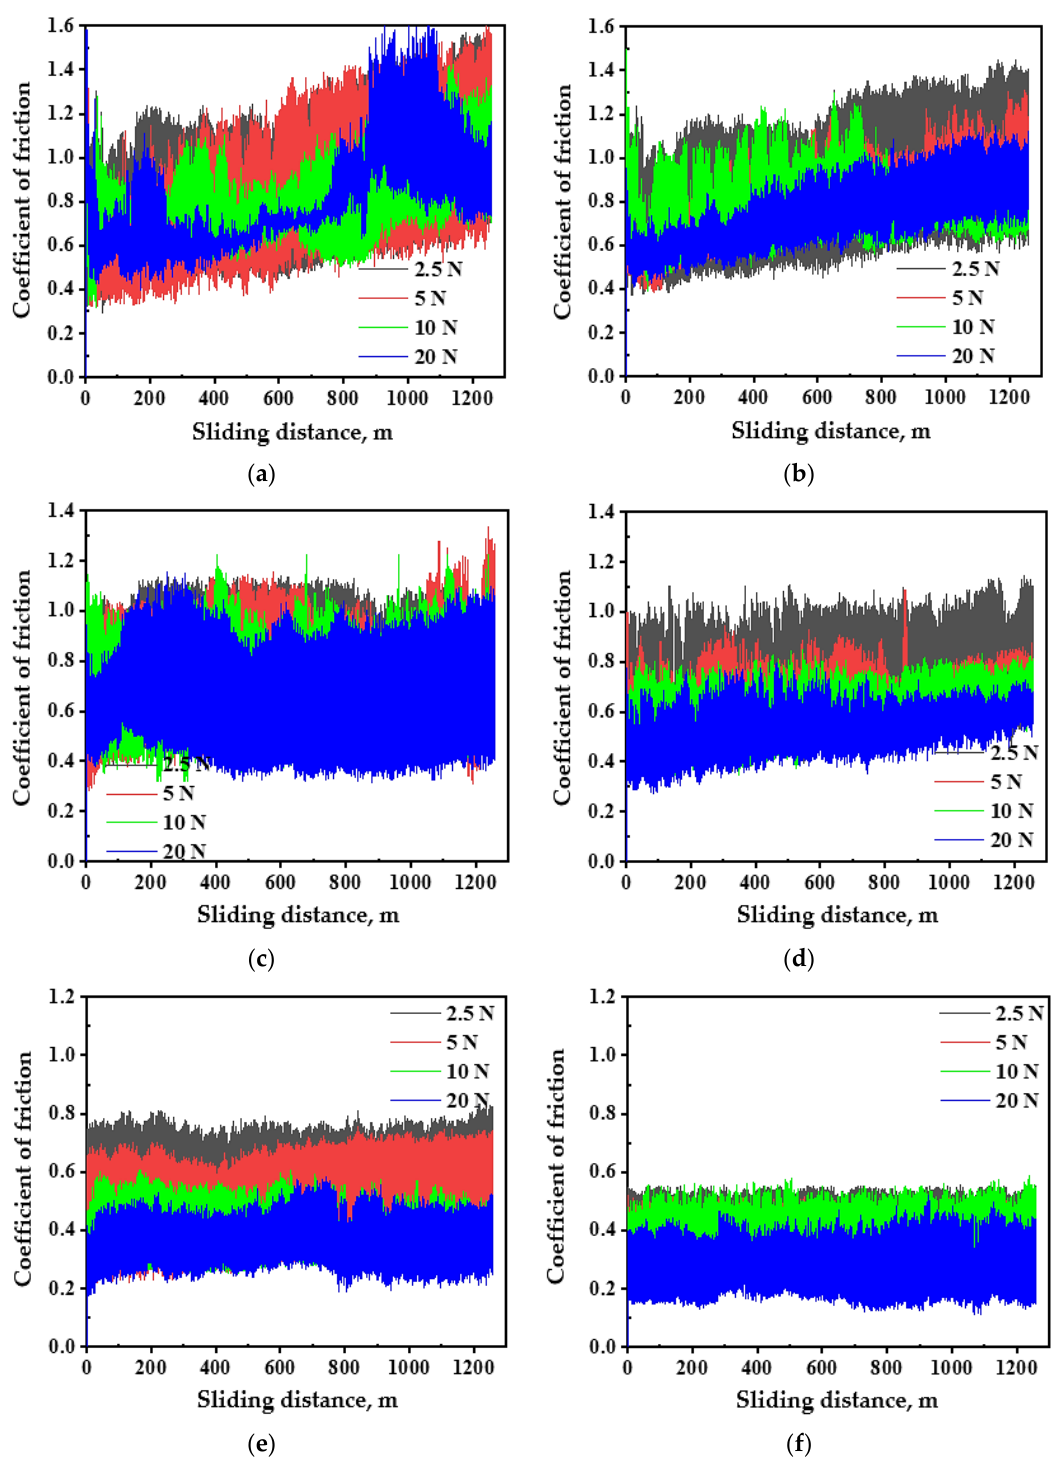
Figure 5 . The COF curves of ( a ) PM Al-20% Al 2 O 3 , ( b ) PM Al-20% SiC, ( c ) HPT-processed Al-10% Al 2 O 3 , ( d ) HPT-processed Al-10% SiC, ( e ) HPT-processed Al-20% Al 2 O 3 and ( f ) HPT-processed Al-20% SiC samples under different applied loads and a sliding distance of 1260 m.